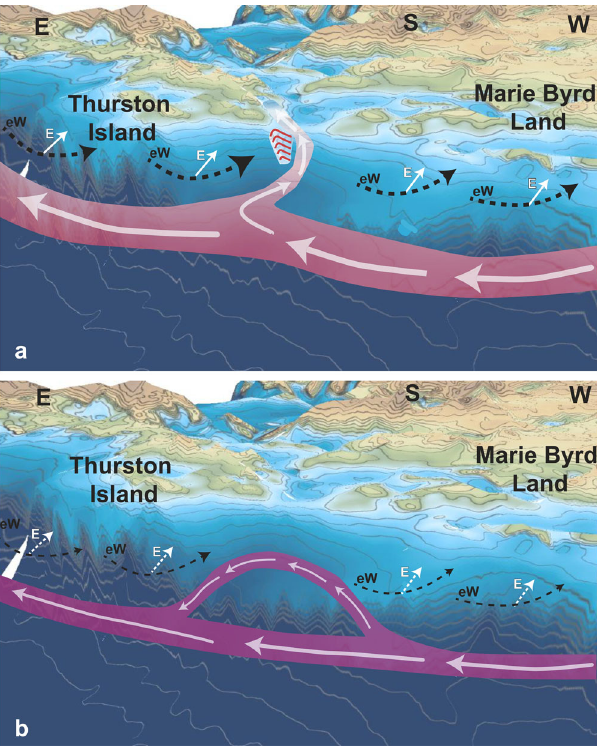
Fig. 7 Conceptual model for the upwelling of deep water onto the ASE shelf in EOT. a The minimum reconstruction of the palaeotopography/ palaeobathymetry for 34 Ma shows a trough mouth or canyon in the shelf break 22,41,82 , which enables the intrusion of deep water (rose arrows) onto the shelf as the result of southward Ekman transport (white E, white arrow) within the easterly winds (eW). The southward fl ow of deep water is steered by the higher topography on the eastern ASE shelf and shapes the sediment drift (red lines). b Later in the Oligocene, increasing global cooling will have relocated the wind system (eW) northwards and in fl uenced the intensity of upwelling. Deep water (purple arrows) now can only upwell into the outer trough and is recirculated back into the deeper ocean. This may have ended the formation of the observed sediment drift plastered against seismic horizon ASS-u2 below the eastern fl ank of the present-day PIT. eW = easterly winds, E, S, W = East, South, West.